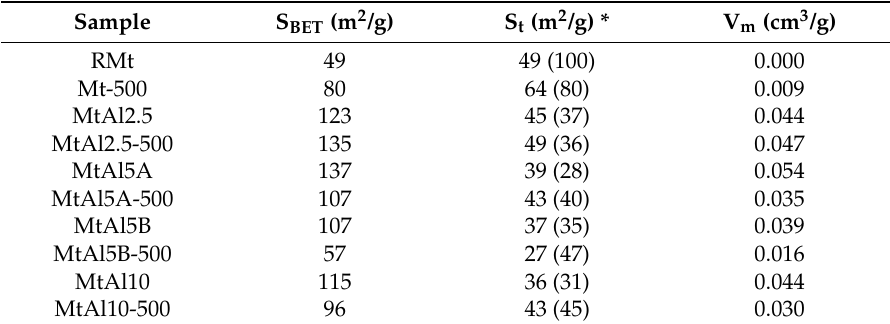
Table 6. Specific surface area (S BET ), external surface area (S ext ) and micropore volume (V m ) of natural montmorillonite [13] and of the pillared